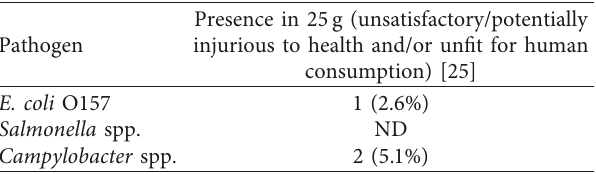
Table 2: Presumptive positive incidence of food-borne pathogens in the raw vegetables salad samples from roast meat eateries ( n � 39).